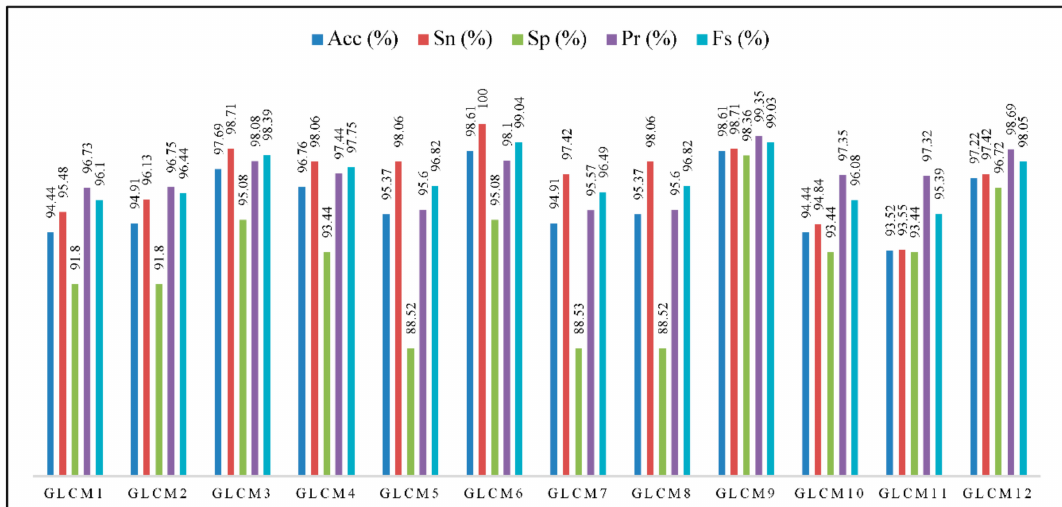
Figure 15. Results of SVM using combined geometric and GLCM features ( GLCM 1 : GLCM 0